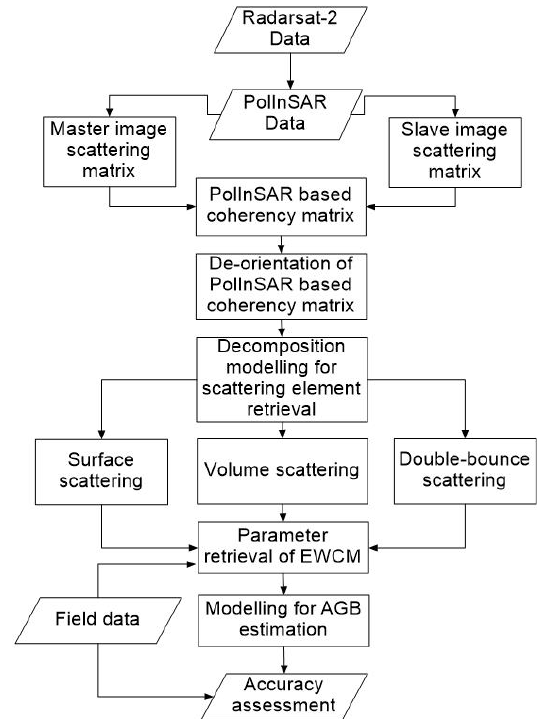
Figure 1: Flow Diagram of